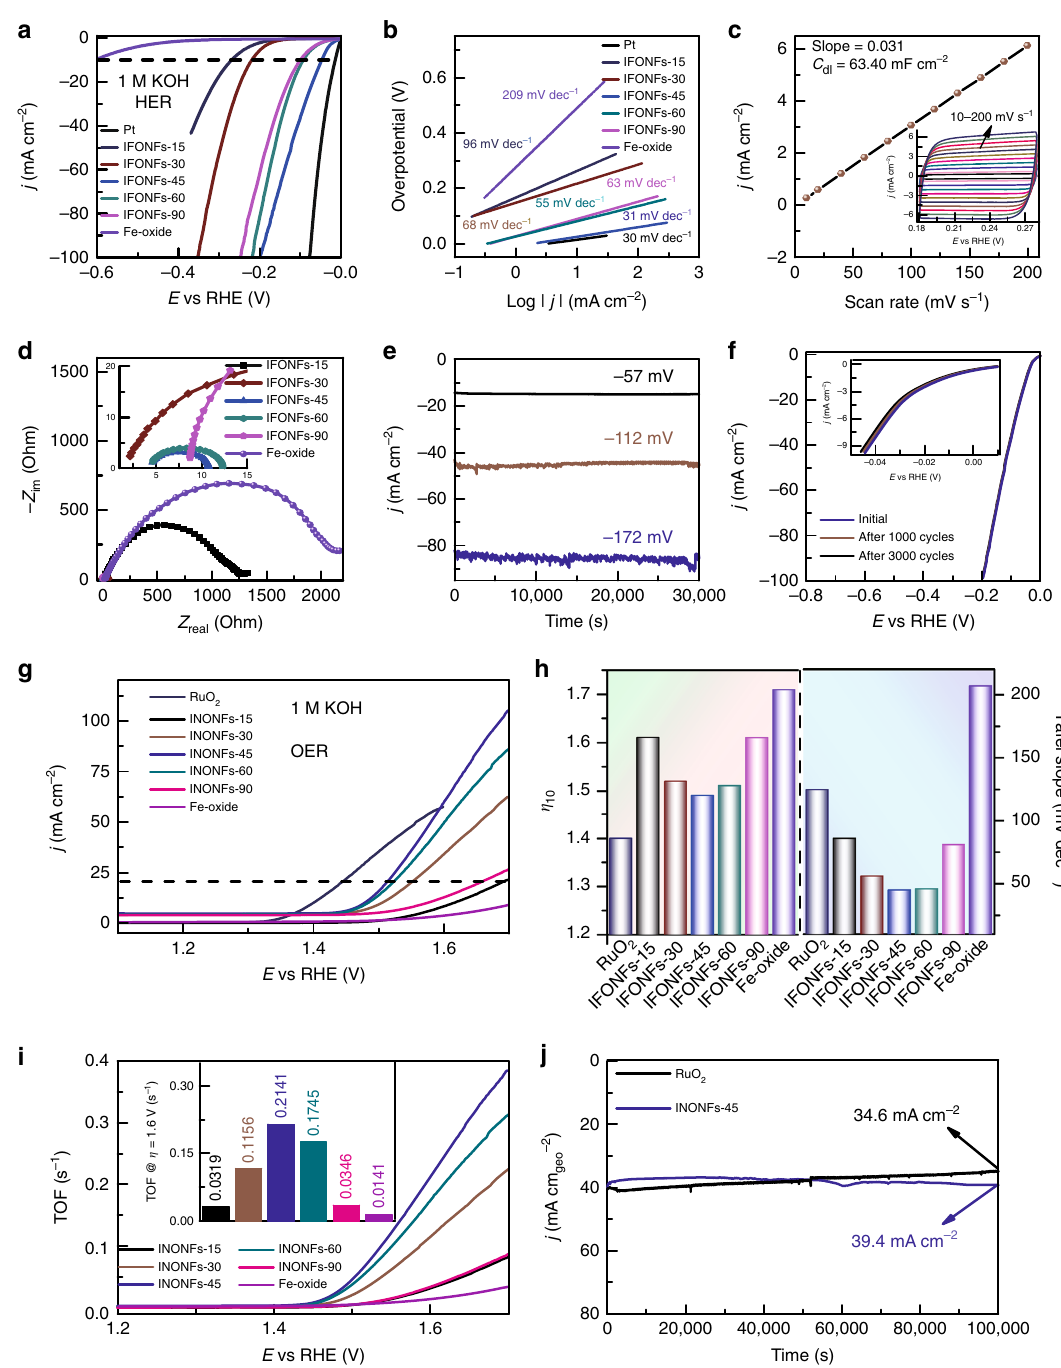
Fig. 4 Electrochemical HER and OER activity of IFONFs. a Polarization curves measured at 50 mV s − 1 in 1 M KOH aqueous solution, and b the corresponding Tafel slopes. c The capacitive current at 0.23 V (vs RHE) as a function of scan rate for IFONFs-45 ( Δ j 0 = j a − j c ). The inset is CVs for IFONFs-45 with different rates from 10 to 200 mV s − 1 . d Nyquist plots measured at a voltage − 5 mV (vs RHE) over the frequency range 1000 – 0.01 Hz in 1 M KOH. The inset is enlarged area denoted by dash squares. e CV cycle-dependent current density at different potentials with 30,000 s in 1 M KOH aqueous solution. f Polarization curves before and after 3000 CV cycles of IFONFs-45 ranging from 0 to 0.2 V vs RHE. g LSV curves measured at 5 mV s − 1 in 1 M KOH aqueous solution, h the corresponding η 10 (left) and Tafel slopes (right) for RuO 2 , IFONFs and Fe-oxide catalysts. i TOF per oxidative iron site for IFONFs and Fe-oxide catalysts. The inset reveals the TOF values at η = 1.6 V. j Time-dependent current density curve of IFONFs-45 and RuO 2 at a fi xed overpotential of 1.56 and 1.52 V to drive 40 mA cm − 2 , respectively. dec, slope and lower overpotential, which could be credited to the defect-rich electrodes. Additionally, the individual Fe 2 O 3 and increased active sites and reduced charge-transfer resistance FeF 2 PTF exhibit lower OER activity than IFONFs (Supplemen- tary Fig. 34), implying that synergistic effects of Fe 2 O 3 and FeF 2 (Supplementary Fig. 33 and Supplementary Table 2), further could be crucial in enhancing OER activity by in fl uencing the con fi rming the feasibility of electrochemically catalyzing OER at